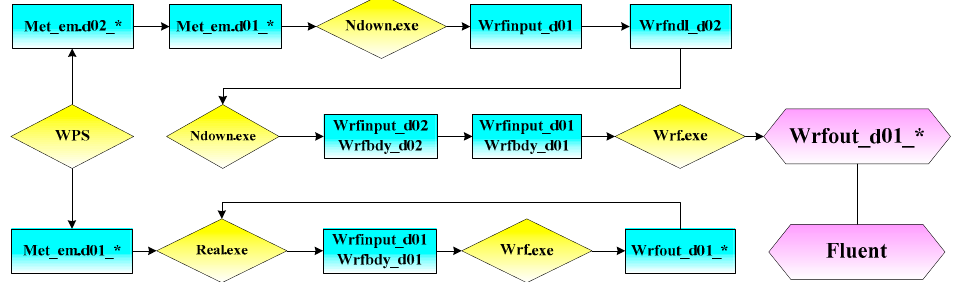
Figure 10. Procedures of WRF / CFD computation and nesting.